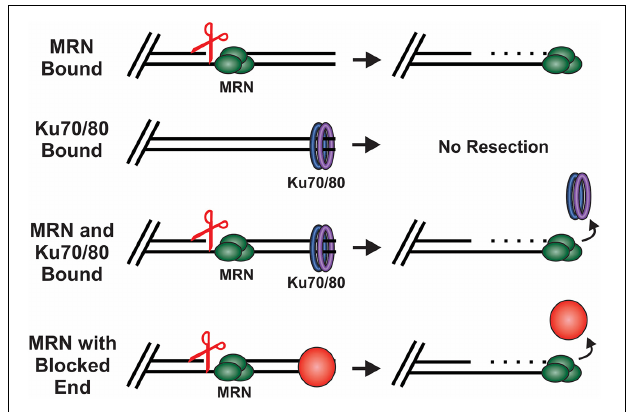
FIGURE 4 | How DSB ends are processed under different conditions. Scissors indicate MRN endonuclease activity. MRN binding to unblocked ends leads to resection of the DNA. When Ku binds in the absence of MRN, no resection occurs. However, when both Ku and MRN are bound, stimulation of the MRN nuclease activity promotes resection and the removal of Ku. MRN can similarly function at ends blocked by a protein adduct, damaged bases or DNA secondary structures.